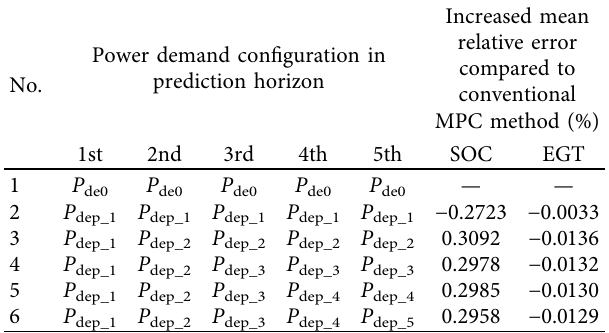
Table 6: Simulation results of different configuration of predictive power demands for the predictor which only adopts velocity as